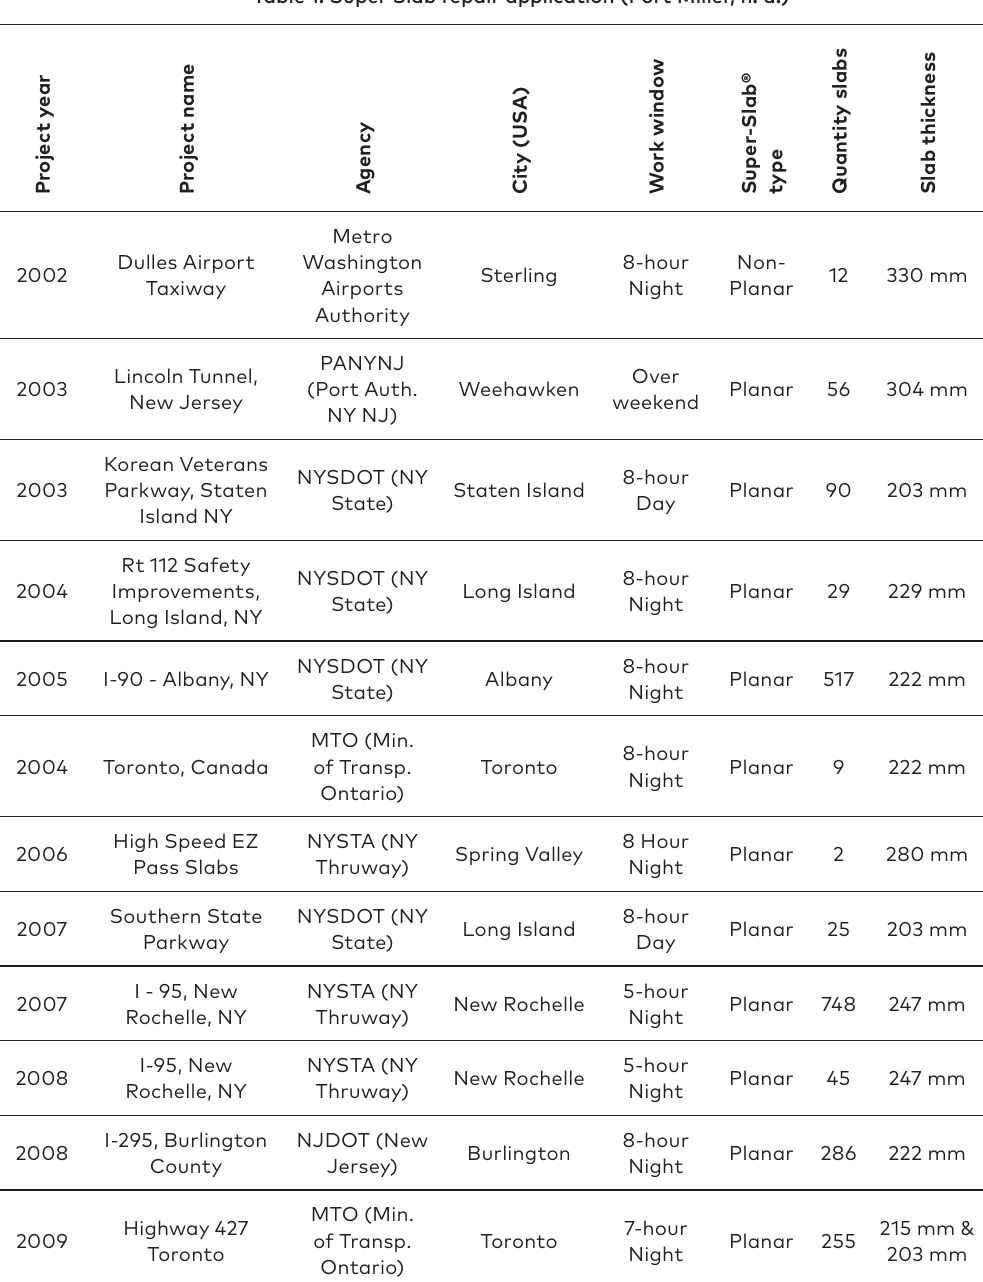
Table 1. Super Slab repair application (Fort Miller, n.